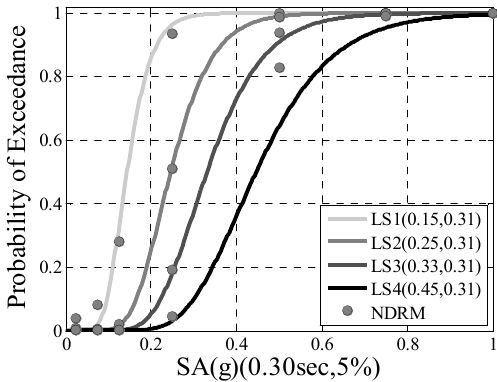
Figure 10 Structure response curves obtained through IDA of SDOF systems. Fig. 10. Structure response curves obtained through IDA of SDOF systems.